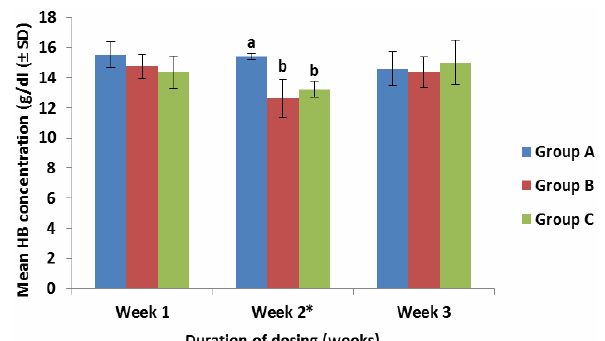
Fig. 2. The mean red blood cell count (x 10 6 ) (± SD) of rat groups given varied doses of methanolic leave extract of T. occidentalis . Group A (untreated control), group B (200 mg/kg body weight daily) and group C (800 mg/kg body weight daily)